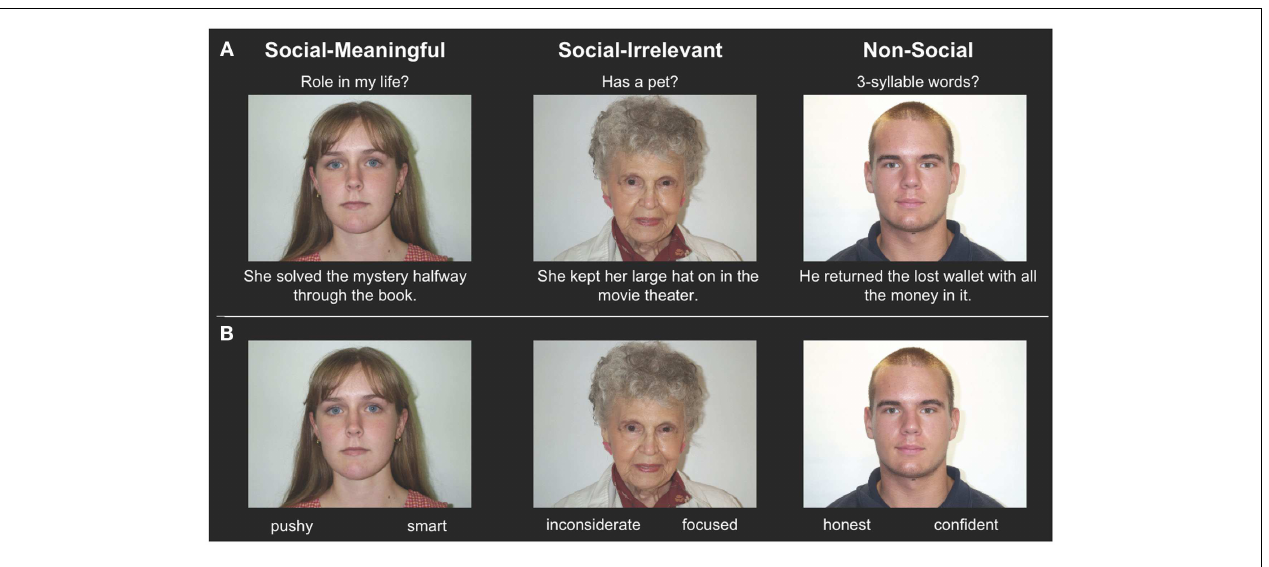
explicitly labeled on the screen, and participants answered yes or no to the displayed prompt. (B) Example retrieval stimuli, showing examples of target and lure traits.